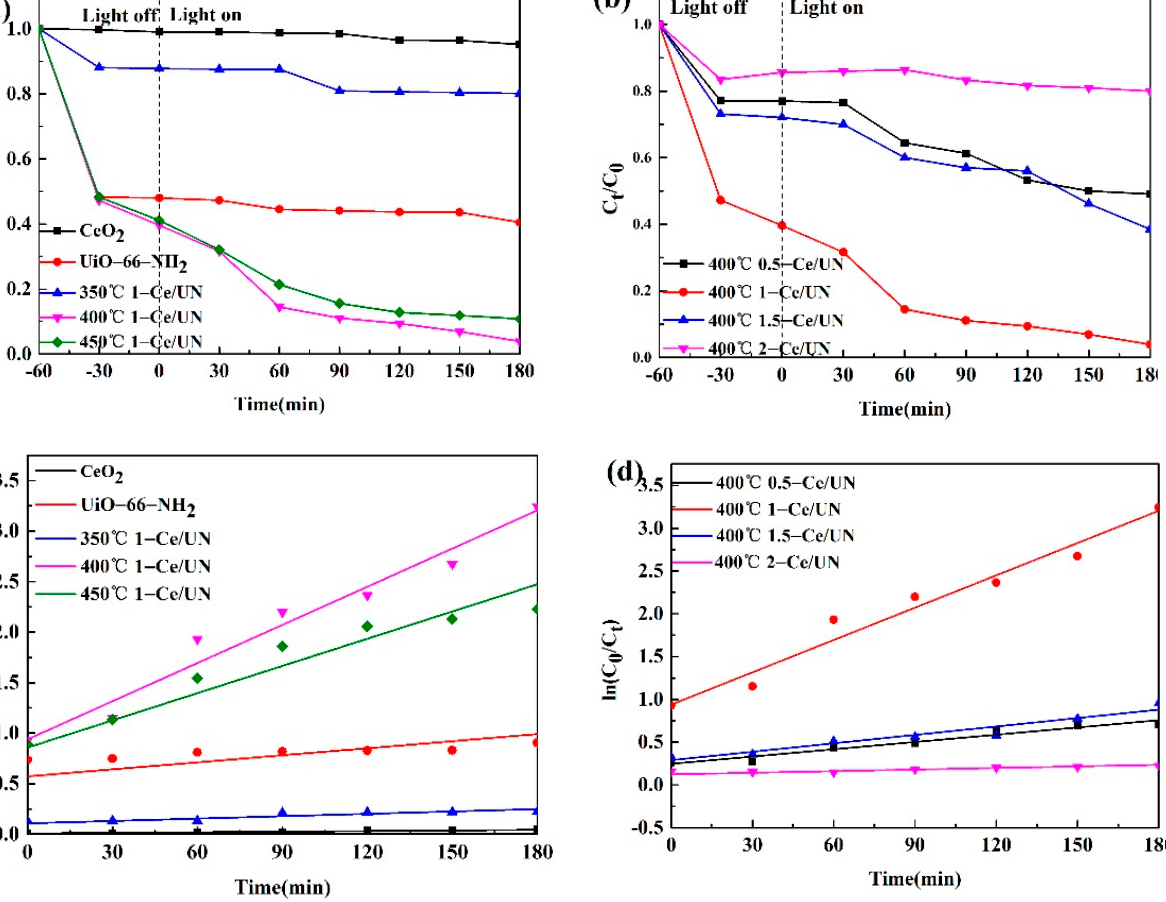
Figure 15. Degradation rate and first-order kinetic K diagram of RhB by CeO 2 , UiO-66-NH 2 , and Ce/UN: ( a ) degradation rate of different temperatures; ( b ) degradation rate of different proportions; ( c ) first-order kinetic K-value diagram of different temperatures; ( d ) first-order kinetic K-value diagram of different proportions.